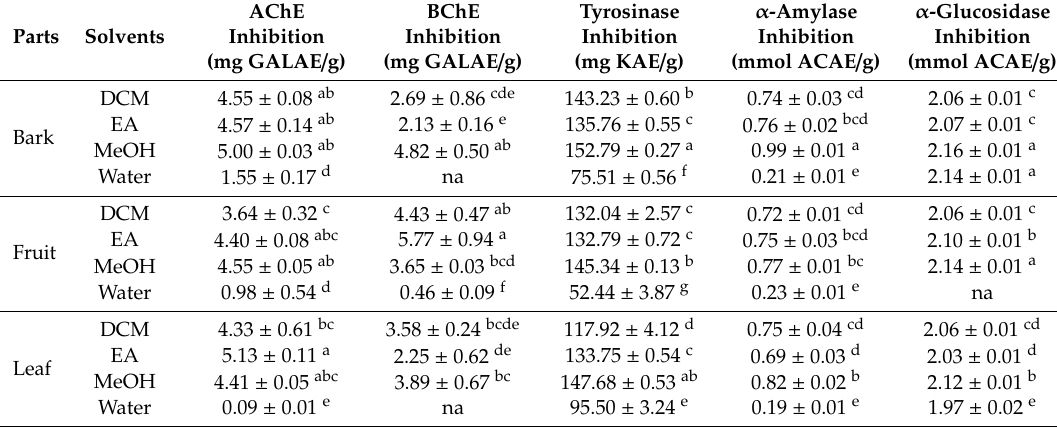
Table 5. Enzyme inhibitory properties of the tested